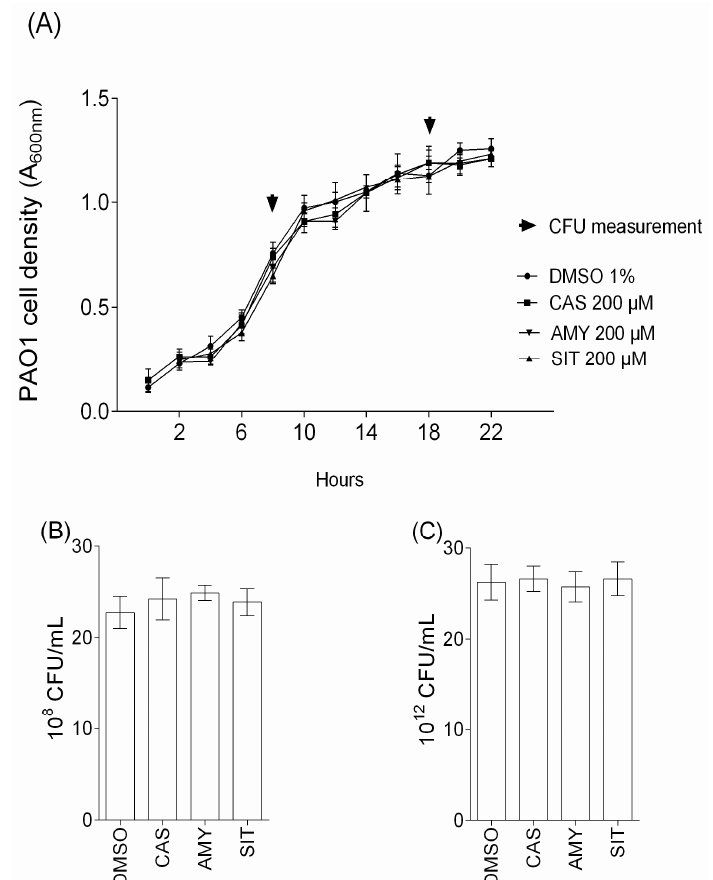
Figure 4. Effect of cassipourol, β -sitosterol and α -amyrin on the growth and viability of P. aeruginosa PAO1. ( A ) Growth kinetics of PAO1 in presence of cassipourol or β -sitosterol or α -amyrin at 200 µM or DMSO 1% over a period of 22 h. The cell density of the bacteria was assessed as A 600nm and colony forming units (CFU) were quantified after: 6 h ( B ); and 18 h ( C ). The statistical significance of each test ( n = 3) was evaluated by conducting One-way ANOVA followed by Dunnett’s test of multiple comparisons (i.e., each test was compared with the control condition, DMSO), and a p value of <0.01 was considered as significant.